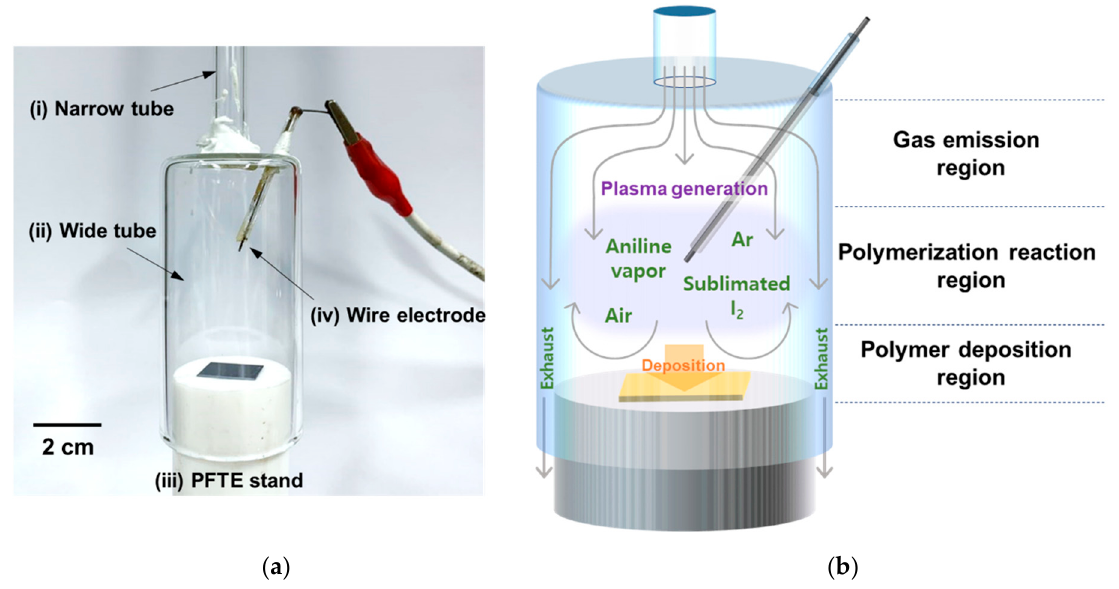
Figure 1. The new atmospheric pressure (AP) plasma reactor design: ( a ) photographic image with the main components labeled, and ( b ) a schematic diagram of the in-situ iodine ( I 2 )-doped plasma polymerization procedure. Abbreviations: PFTE: polytetrafluoroethylene.